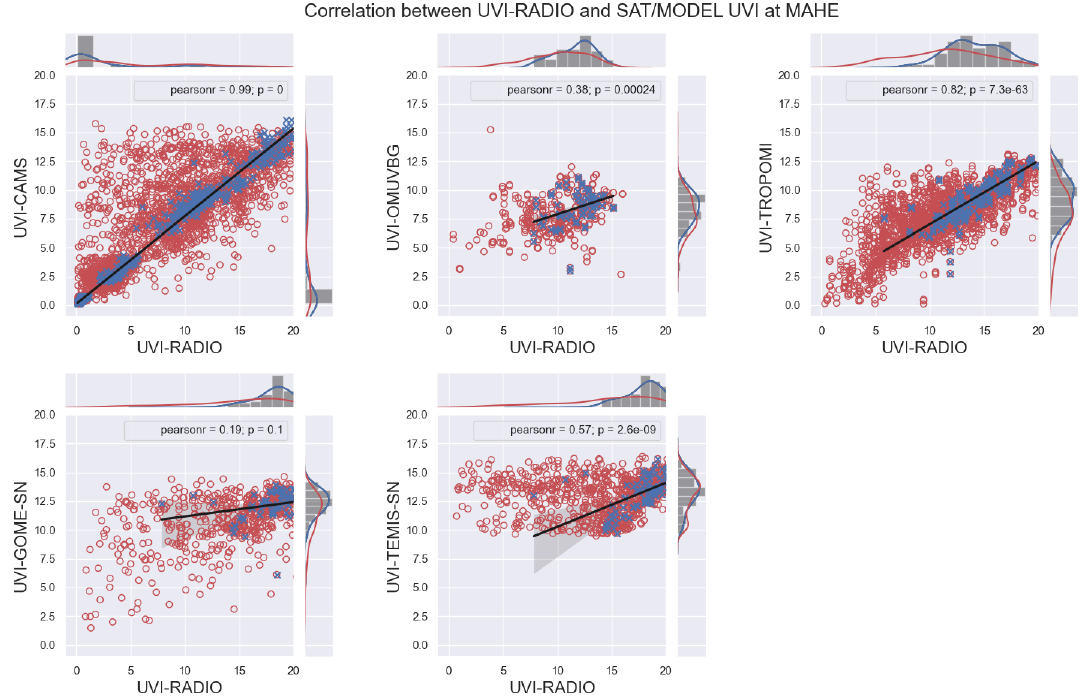
Figure A5. Correlation between UVI-RADIO and satellite/model estimates at Mahé. A histogram representing each dataset distribution is represented at the right and at the top side of each subfigure. The clear-sky measurements made by UVI-RADIO have been distinguished and are shown as blue crosses, while the measurements for all-sky conditions are shown as red circles.